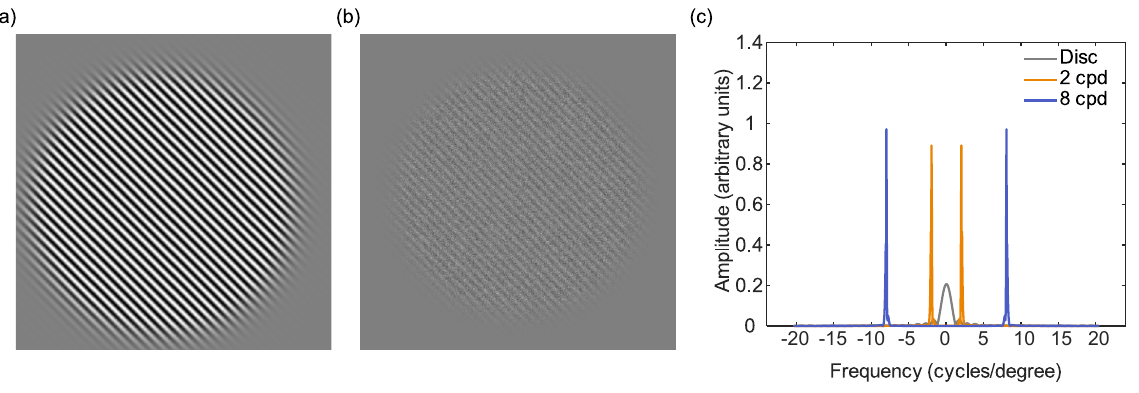
Figure 1. Schematic diagram of the stimuli used in the current experiment: ( a ) the 8 cpd target sine grating (exact spatial frequency content will vary as this is dependent on distance). ( b ) the target and Gaussian noise mask. ( c ) The Fourier transform of the stimuli, showing frequency plotted against amplitude (arbitrary units) for the disc used by Wagner et al. [18] (grey) the 2 cpd (orange) and the 8 cpd (blue) stimuli. The disc stimulus covers a wider range of spatial frequencies compared to the sine gratings that bias the visual system to preferred